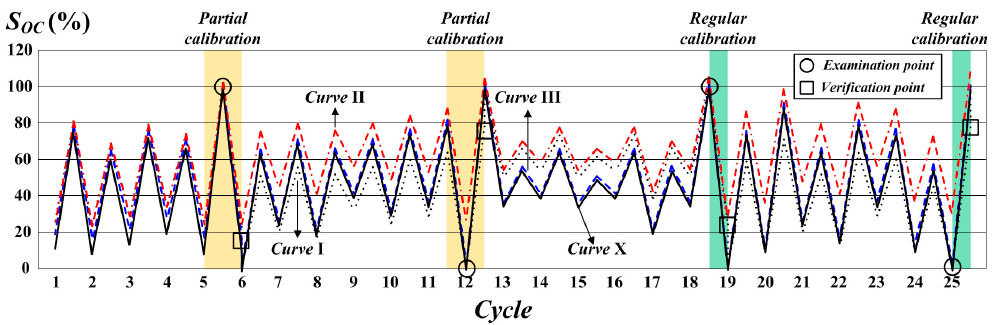
Figure 4. The SOCs on the tested battery cell.